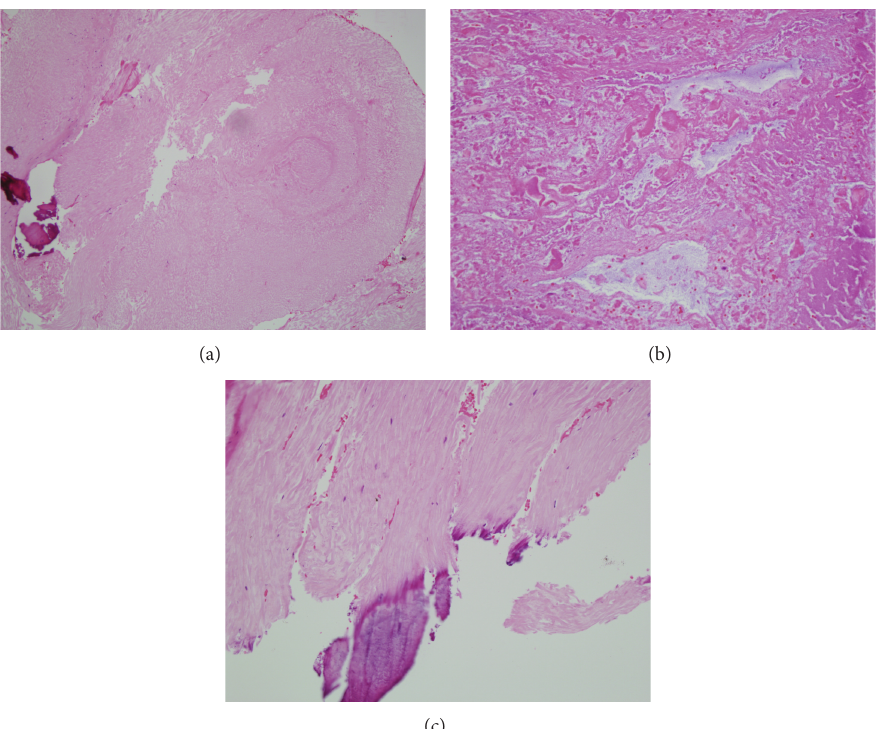
Figure 2: Low power haematoxylin and eosin (H&E) stain (a) showing fibroelastic tissue with patchy myxohyaline degenerative change. Fragments of debris and myxoid material, consistent with degenerative cyst contents (b). Fibroelastic tissue showing dystrophic calcification